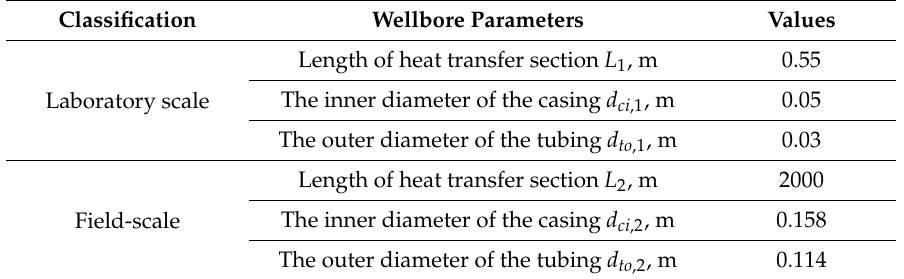
Table 4. Wellbore size and reservoir temperature on the laboratory and